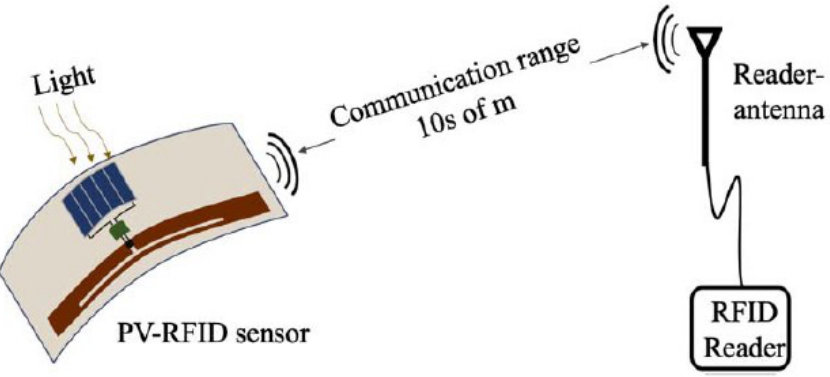
Figure 28. Model of the chip-based ambient energy-harvesting temperature sensor